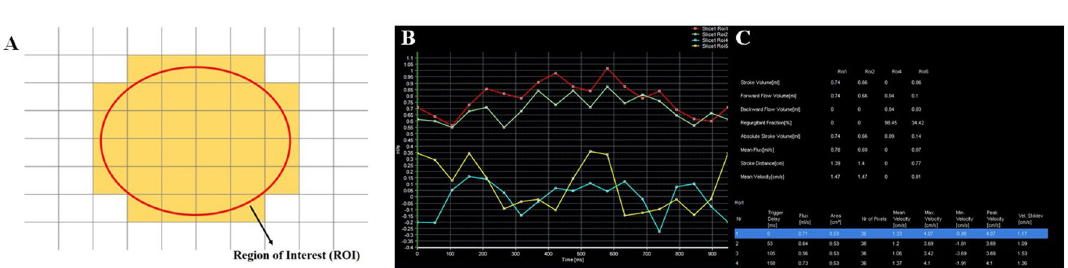
Figure 2. QFlow scanning through TRANCE-MRI. ( A ) Drawing Region of Interest (ROI) of pixel-by-pixel MRI image. ( B ) Two great saphenous veins and two popliteal veins with flow sequence by time. ( C ) QFlow parameters include stroke volume (SV), forward flow volume (FFV), mean flux (MF), stroke distance (SD), and mean velocity (MV) with different trigger